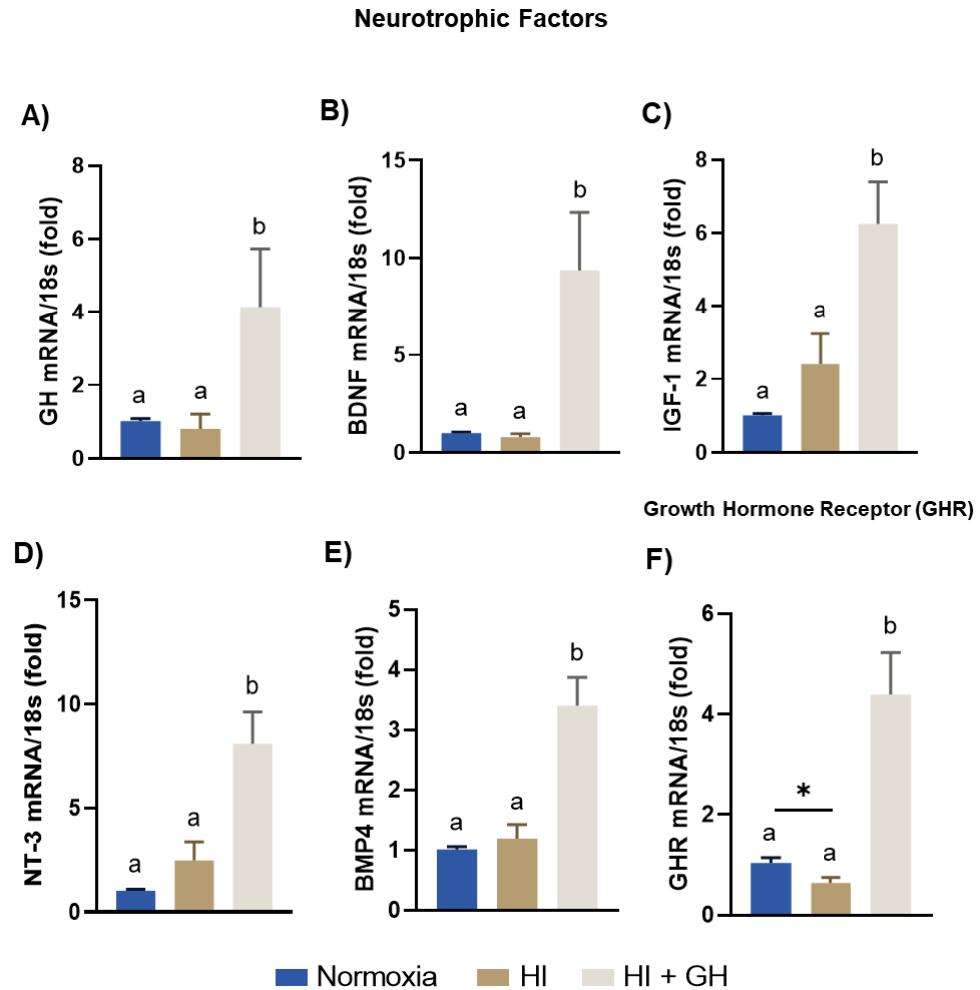
Figure 7. Effects of growth hormone (GH) upon endogenous neurotrophins and GHR expression after exposing pallial cultures to HI injury. Panels show the expression of: ( A ) GH, ( B ) BDNF, ( C ) IGF-1, ( D ) NT-3, ( E ) BMP4, and ( F ) GHR mRNA, determined by RT-qPCR, under each incubation condition (normoxia, HI, HI + GH). Relative mRNA expression values were corrected by the comparative threshold cycle (Ct) method and employing the formula 2 − ∆∆ CT . Ribosomal 18s RNA was used as the housekeeping gene. Bars represent mean ± SEM (from 4 independent experiments in duplicate; n = 8 cultures per group). Groups with different letters are significantly different by one-way ANOVA with Tukey’s post hoc test ( p < 0.05). An unpaired Student’s t test was used to compare normoxia vs. HI (panel F ), and asterisks (*) indicate a significant difference (* p < 0.05).